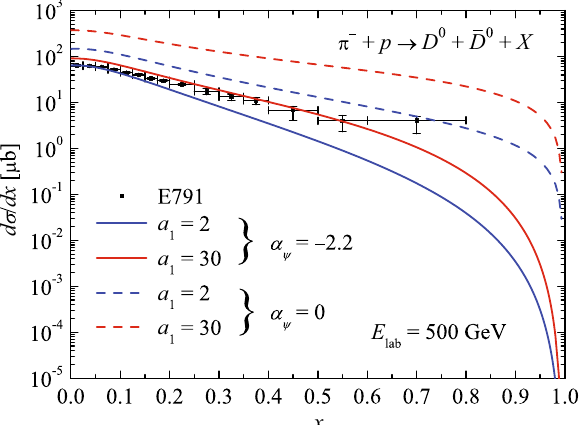
Fig. 5 Differential cross sections of D / ¯ D mesons production in π p collisions calculated in the QGSM at E lab = 360 GeV. Same notation for lines as in Fig. 3. Experimental data for E lab = 350 GeV (WA92) [47], and for E lab = 360 GeV (NA27)